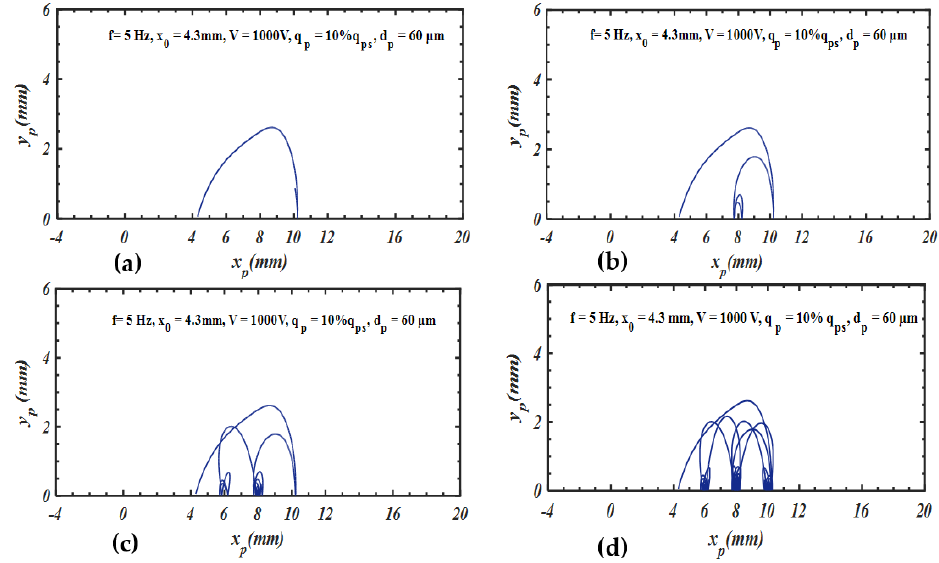
Figure 4. Trajectories of one single particle at several instants: ( a ) 50 ms, ( b ) 100 ms, ( c ) 200 ms, ( d ) 500 ms. Conditions: 𝑉 = 1000 V, 𝑓 = 5 Hz, 𝑑 𝑝 = 60 µm, 𝑞 𝑝 =10% 𝑞 𝑝𝑠 (positive polarity), 𝑥 0 = 4.3